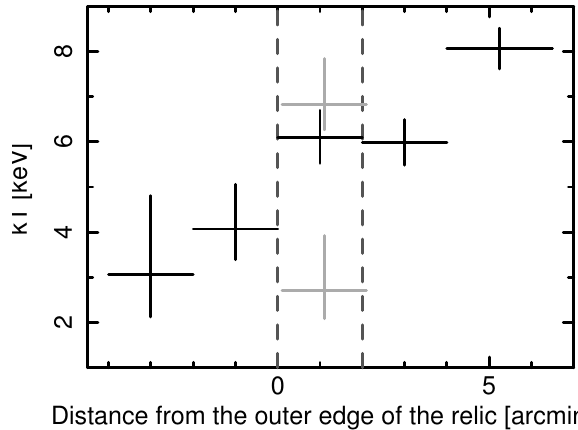
Figure 2. The temperature profile of the 1RXS J0603.3+4214 across the “toothbrush” relic from [6]. The horizontal axis represents the angular distance from the relic outer edge. Inward and outward directions are positive and negative, respectively. The inner and outer edge positions of the relic are displayed in dotted lines. Light gray crosses show results when Region R3 in Figure 1 is divided into eastern and western regions.